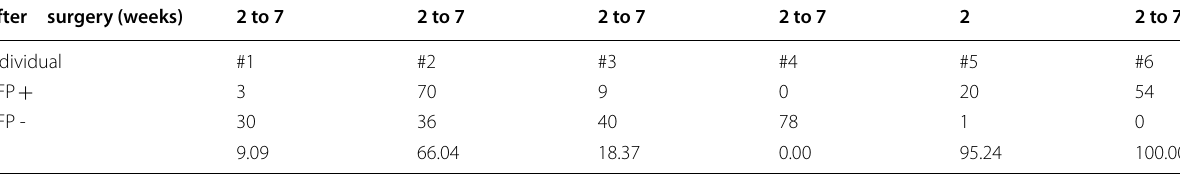
GFP-positive eggs, which indicates fertilization by sperm from the allogenic or isogenic donor testis, were produced by four of the 10 (individuals #1 ~ #4) or two of the four (individuals #5 and #6) recipient males, respectively